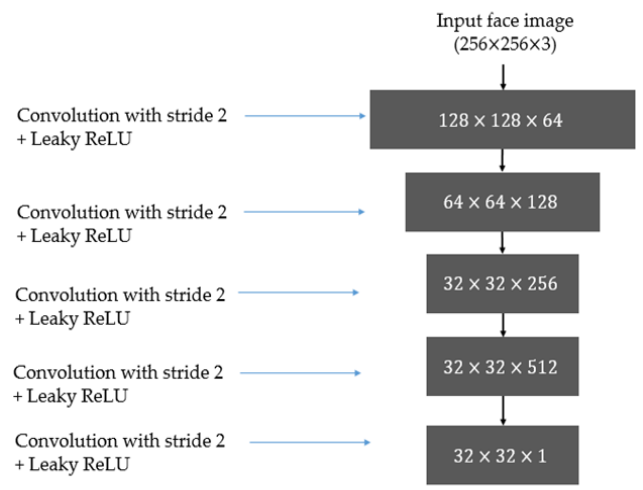
Figure 4. Illustration of the discriminator network used in our study.